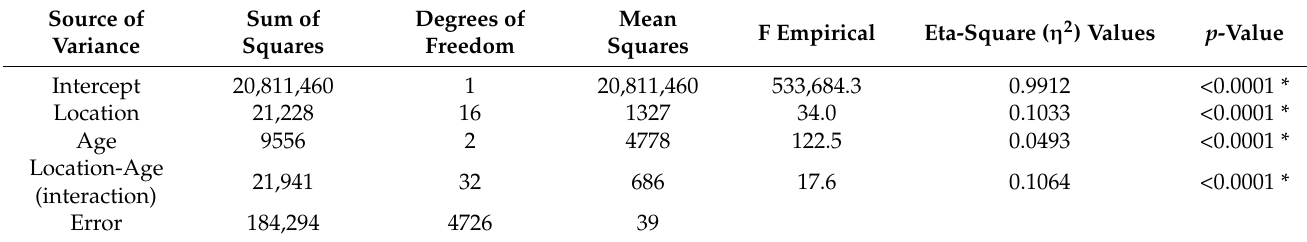
Table 1. Effect of location and tree age and the interaction of these factors on wood hardness (two-way analysis of variance). Source of Variance